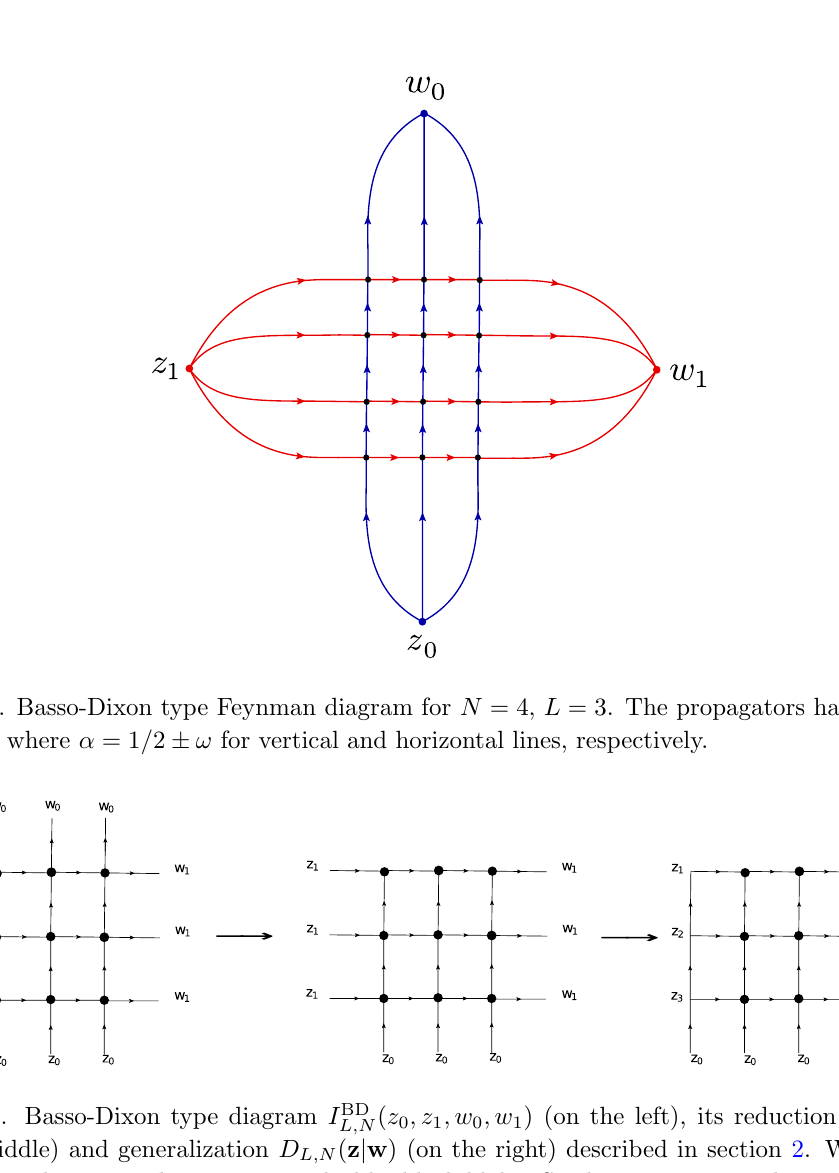
( z 0 ; z 1 ; w 0 ; w 1 ) (on the left), its reduction G L;N ( z w ) L;N j w ) (on the right) described in section 2. We integrate j in the original Basso- ! 1 ( z 1 ; z 2 ; : : : ; z N ) and w 1 ( w 1 ; w 2 ; : : : ; w N ), ! ! z i +1 ] (cid:0) (cid:13) , thus getting the generalized (cid:0)